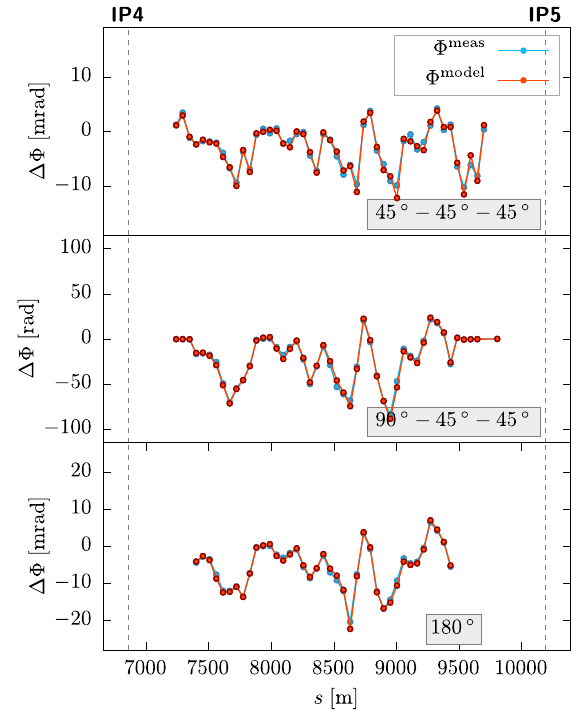
FIG. 6. This figure shows the first two combinations of Table III and the case φ m ij ¼ π from simulations. Top: the combination 45 ° − 45 ° − 45 °. Center: the combination 90 ° − 45 ° − 45 °. The absolute value of the local observable in the telescopic arc (right of IP4) is 4 orders of magnitude higher than in the top plot. The plots only show values where the phase advances do not differ more than 1° from the target values displayed in Table III in order to ensure comparability between the values. Additionally values with a model phase advance in n π (cid:5) 10 − 6 are excluded to avoid numerical instabilities. This causes the IR to be empty of local phase advances. Note that in the middle plot the values are 4 orders of magnitude higher than in the other two. This originates from the cot φ m il terms which are high because of φ m il ≈ π . The bottom plot shows the local observable for model phase advances of 180°. In all three plots the agreement between model and simulation is